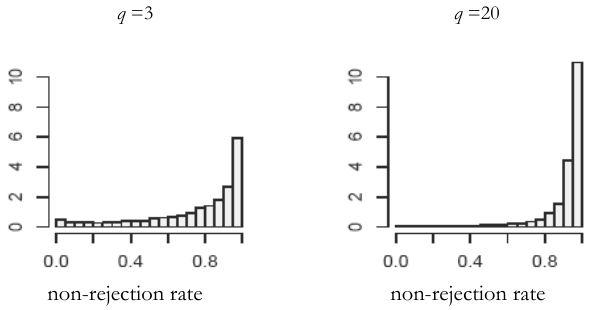
Figure 3 – Histograms of the estimated values of the non-rejection